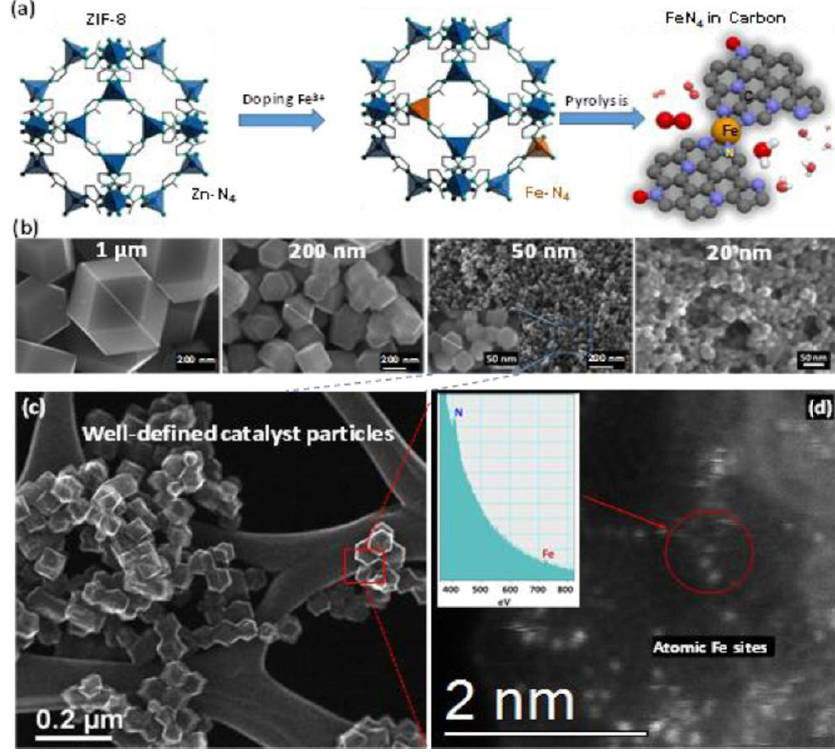
Figure 3. ( a ) Schematic representation of the synthesis process of Fe-doped ZIF catalysts. ( b ) Precisely controlled Fe-ZIF catalysts with sizes ranging from 20 to 1000 nm. ( c , d ) HAADF-STEM images of the highest performing Fe-doped ZIF catalyst (50 nm) and EELS analysis results (inset of ( d )). (Reprinted with permission from [56]. Copyright 2017, American Chemical Society).